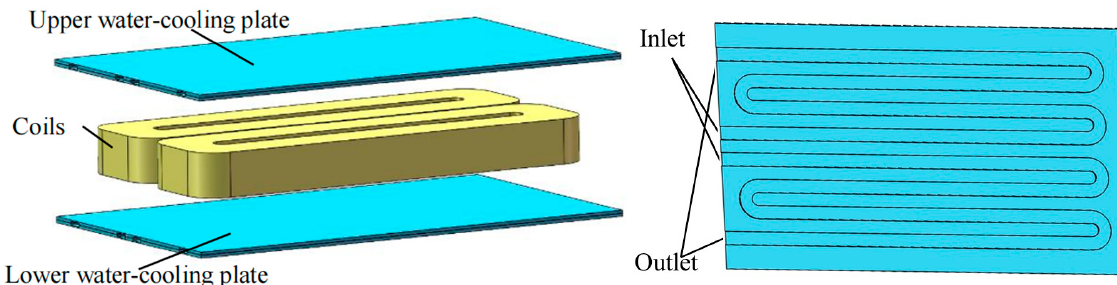
Figure 9. Cooling structure of the linear voice coil motor.